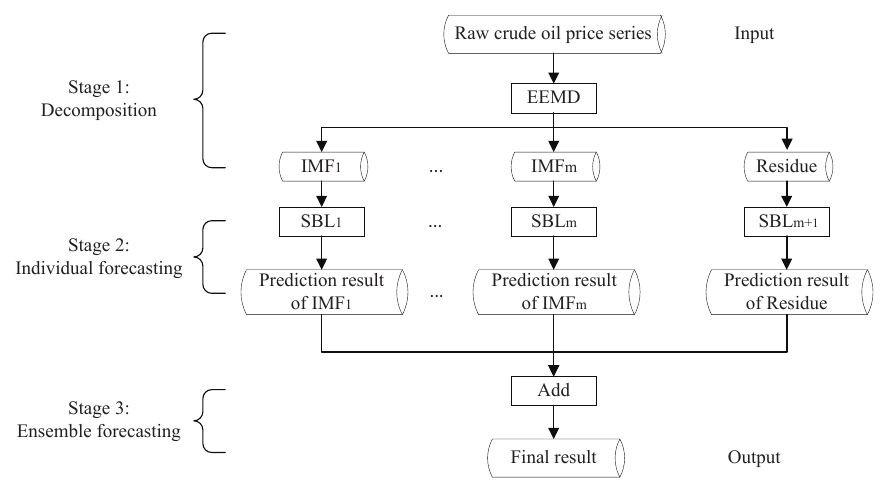
Figure 1. Flowchart for the proposed approach. EEMD: ensemble empirical mode decomposition; IMF: intrinsic mode function; SBL: sparse Bayesian